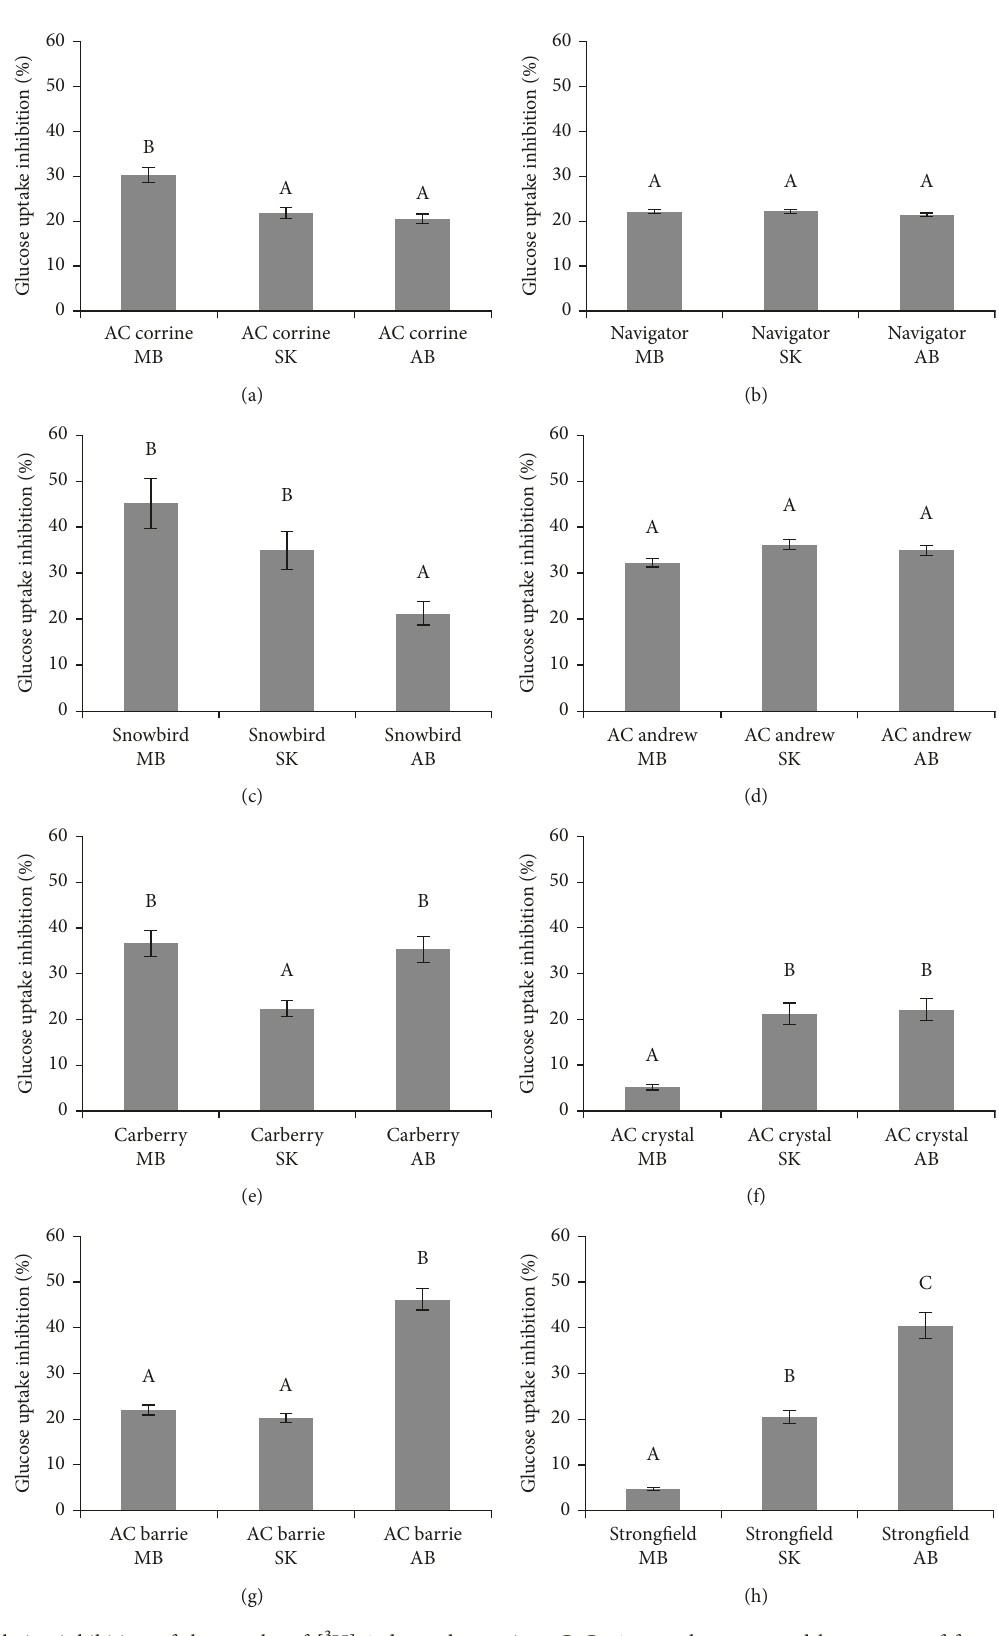
Figure 1: Relative inhibition of the uptake of [ 3 H] 2-deoxyglucose into CaCo-2 monolayers caused by extracts of free phenolic acids obtained from eight wheat genotypes (a–h) grown in MB, SK, and AB over 2010 crop year. A,B,C Different capital letter superscripts indicate significant differences ( P 0 . <